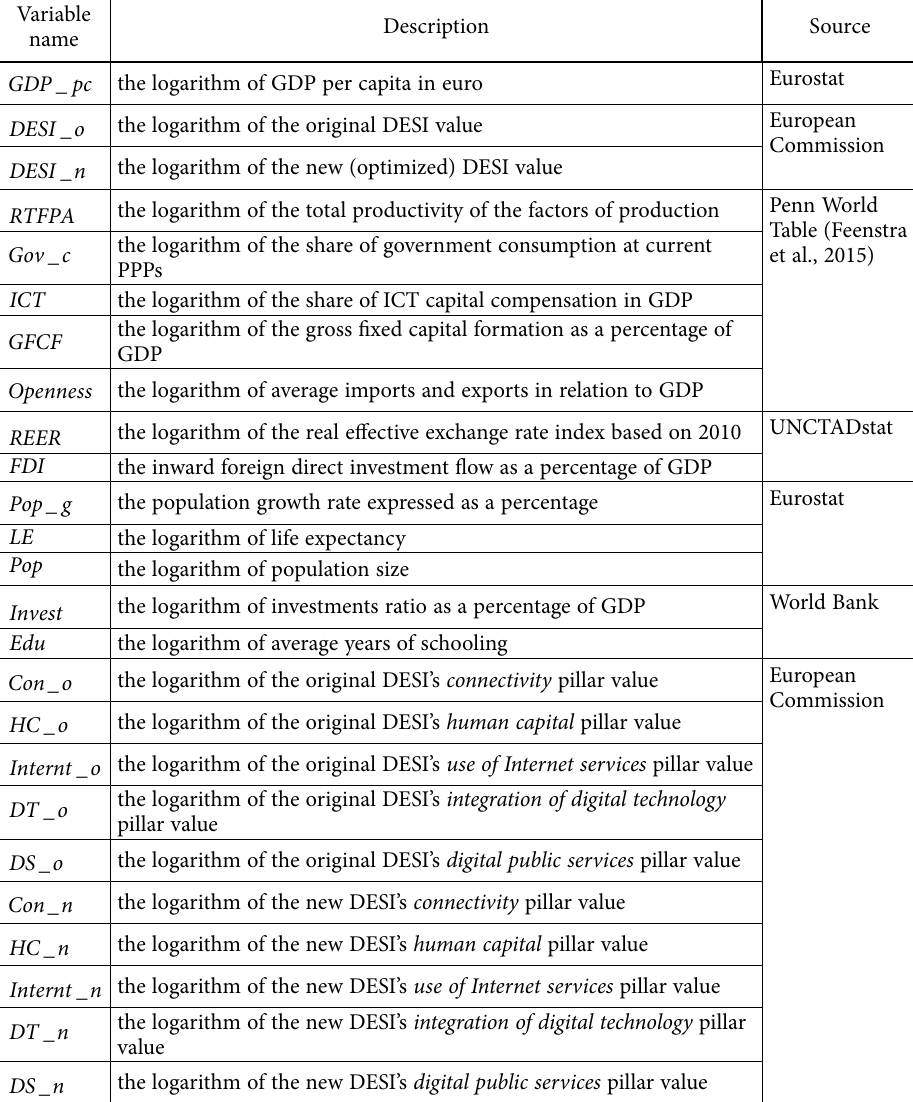
Table 1. Variables used in the